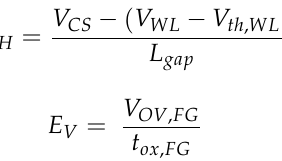
Figure 2. ESF3 cell representation with operating electrical conditions.